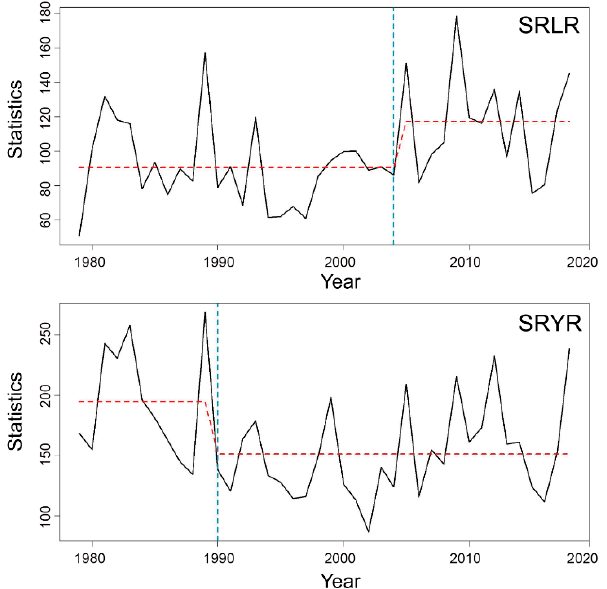
Figure 8. The abrupt change in the runoff in the SRLR and SRYR during 1979–2018; the black line represents the temporal variation in runoff; the red line represents the multi-year mean runoff before and after the abrupt change; the blue line indicates the year of the abrupt change.